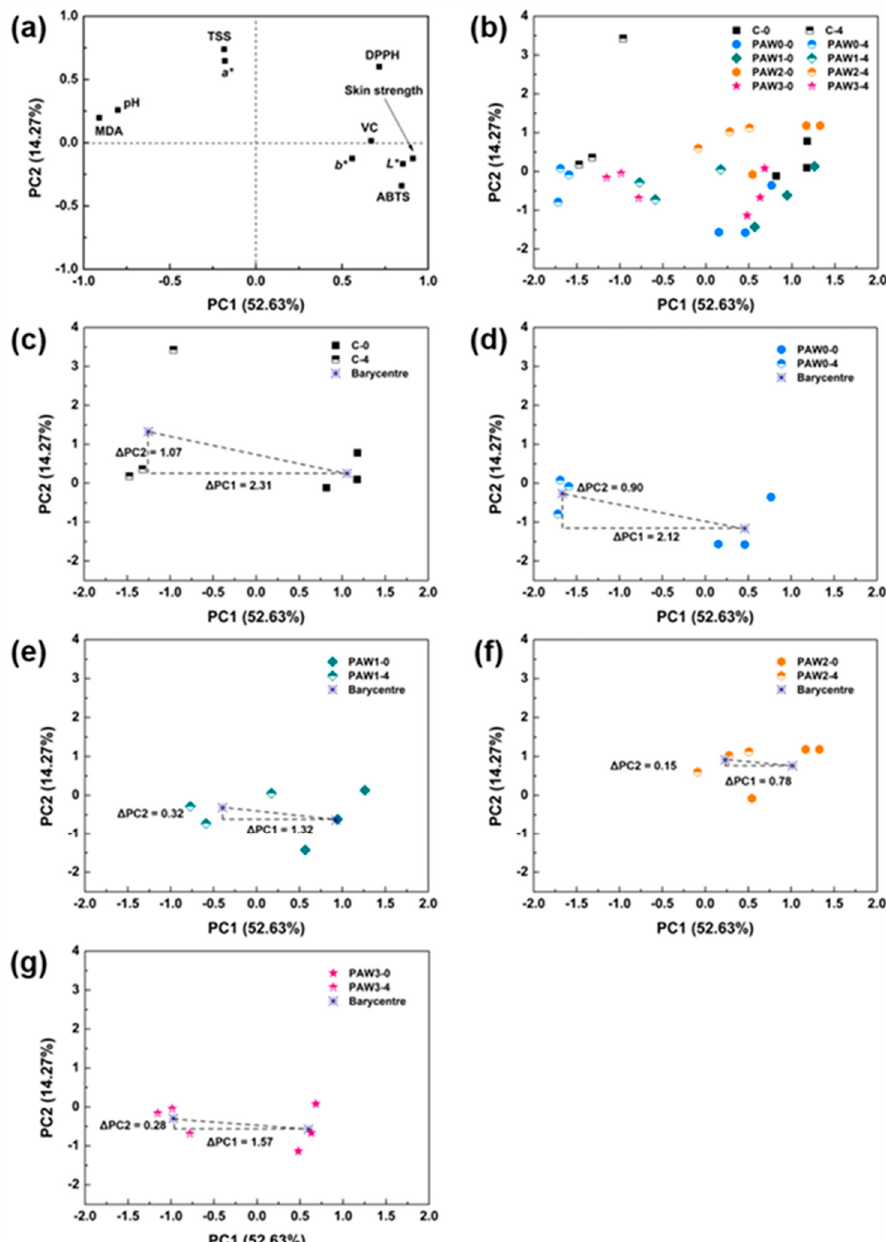
Figure 5. Principal component analysis (PCA) of the strawberry quality, comparing fresh strawberries, strawberries after PAW treatment (0 d), and strawberries after storage (4 d). ( a ) Loading variable plot of PCA. ( b ) Comprehensive PCA score plot comparing fresh strawberries to strawberries after 0 and 4 days when subjected to various treatments. Individual PCA score plots of no-treatment control ( c ), PAW 0 ( d ), PAW 1 ( e ), PAW 2 ( f ), and PAW 3 ( g ) for evaluation of the general quality changes of strawberries during storage, comparing quality after 0 and 4 days.